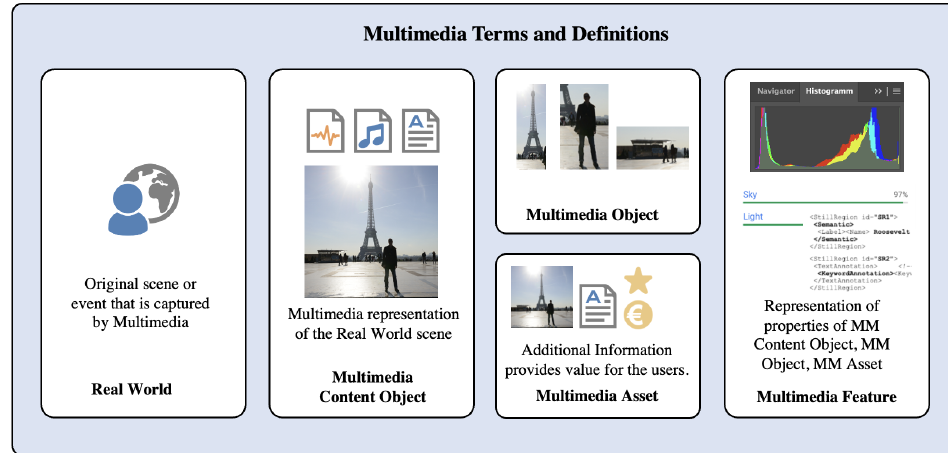
Figure 1. Multimedia terms and definitions.